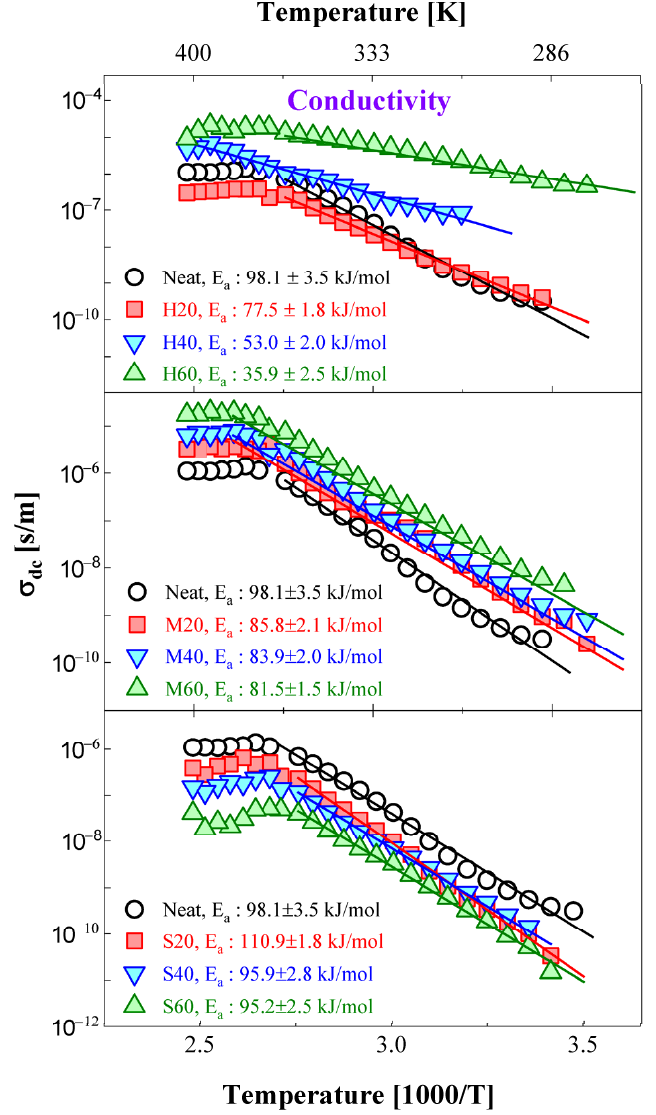
Figure 12. Temperature dependence of DC conductivity for NBR blends with different filler types and contents. The activation energies for each conduction process were determined to show an Arrhenius temperature dependence, as represented by the solid line. The conductivity data multiplied by arbitrary values can be better distinguished by downshifting on the conductivity axis. For comparison, three identical neat NBR results are shown on the top, middle, and bottom sides of each figure.